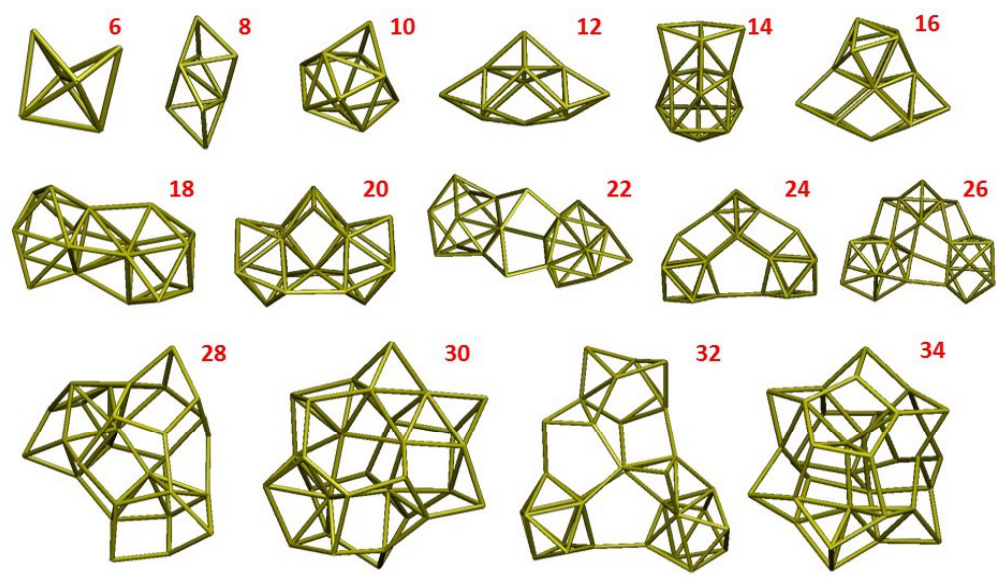
Figure 1. Lowest-energy structures of Si clusters with an even number of atoms and size in the range